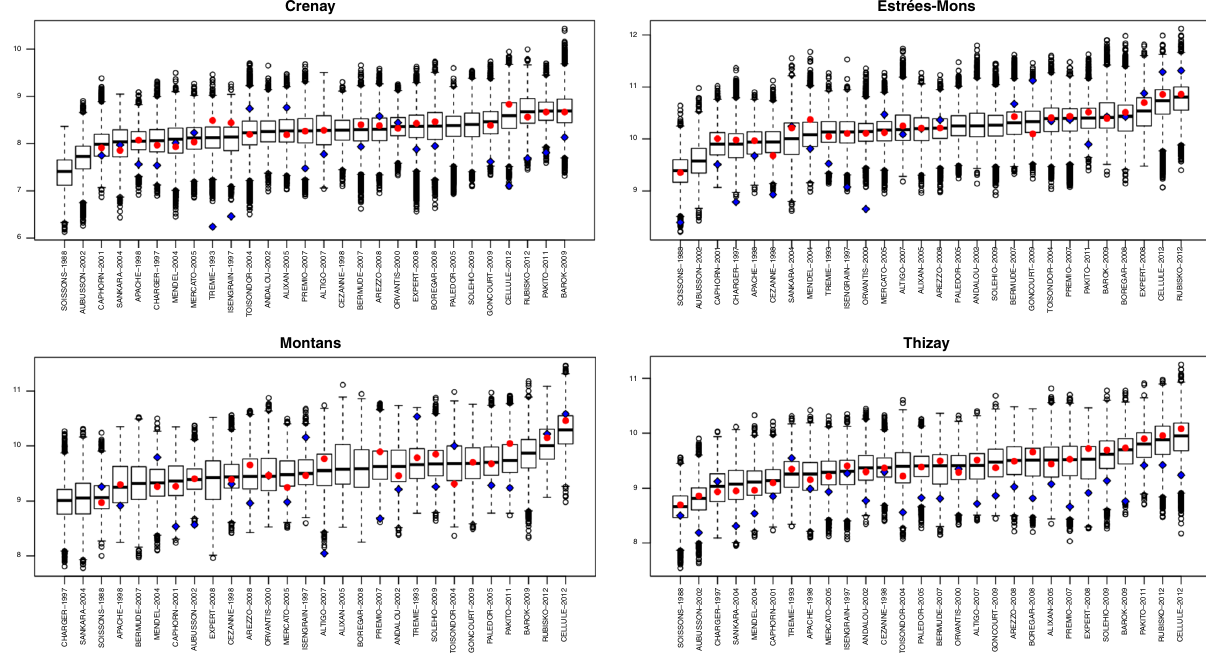
Fig. 6 Distribution of simulated grain yield in selected cultivar – location combinations. The boxes summarize the predicted distribution of yields for each cultivar – location combination across 16 years of likely weather conditions (the line in the middle of the box represent the median, and the edges represent the 1st and 3rd quartiles). The red circles (blue diamond) represent the raw (BLUEs) genotype-by-location mean for the locations where each cultivar was